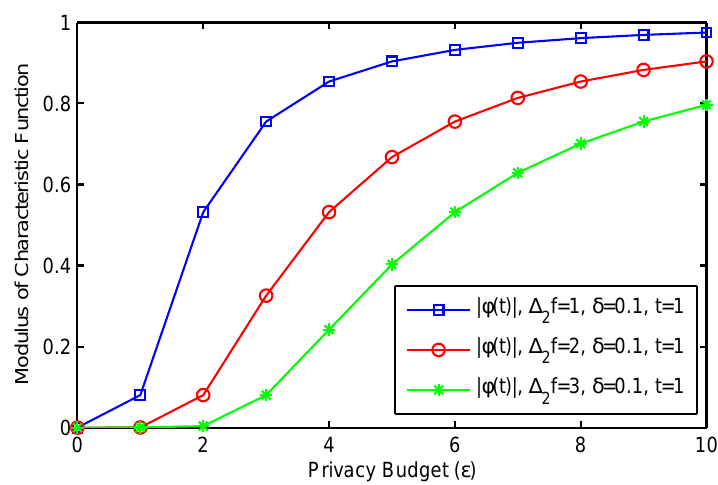
Figure 6. Modulus of characteristic function of query results of Gaussian mechanism.